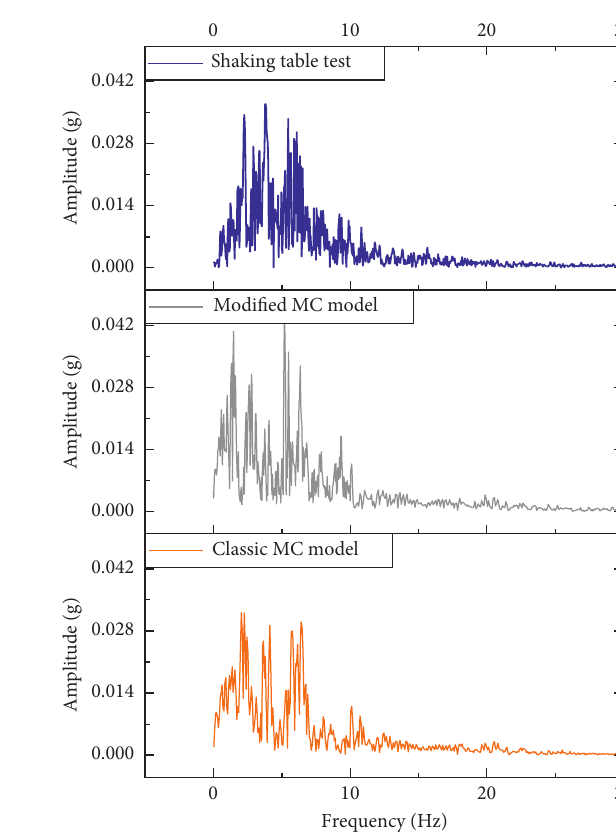
Figure 17: Frequency-domain analysis of point